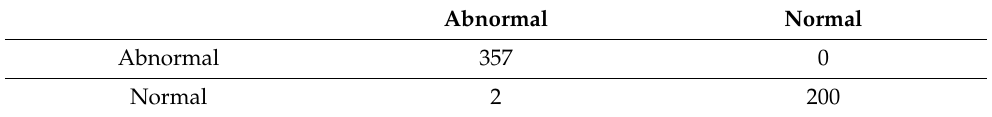
Table 4. Confusion matrix for the OASIS dataset using the BTR method.